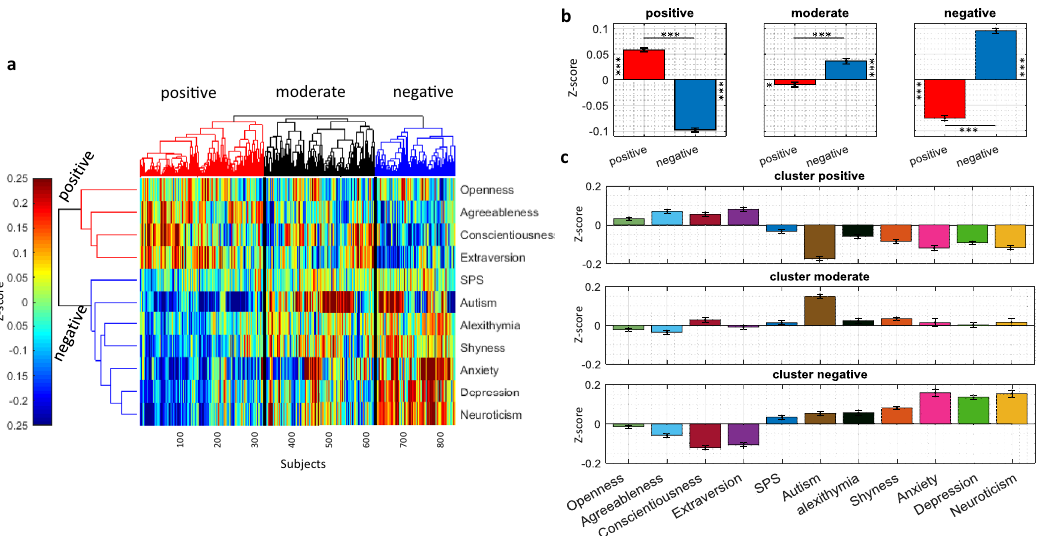
Figure 1. Trait z-scores across all subjects and hierarchical clustering of traits and subjects. ( a ) Clustergram of 837 subjects (columns) color-coded z-scores in 11 traits (rows) with rows and columns sorted by unsupervised HC (Methods). Subjects are clustered into three groups (positive, moderate and negative) and traits are clustered into two groups (positive and negative) as shown by dendrograms on top and on left, respectively. ( b ) Average z-score of positive traits and negative traits cluster in the three subject clusters of positive (t 327 = 25.11), moderate (t 295 = − 6.17), negative (t 212 = − 21.81) for all p < 1e−13. * p < 0.05, ** p < 1e−2, *** p < 1e−3 here and through-out ( c ) Average z-score of individual traits within each subject clusters. Error bars indicate s.e.m. here and through- out.